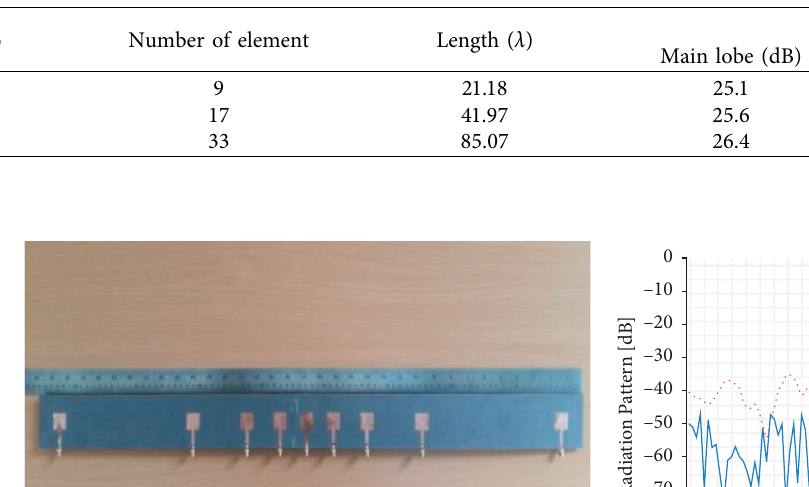
Figure 6: 33-Element sparse array configuration radiation pattern. Table 3: The simulation result of proposed sparse array.